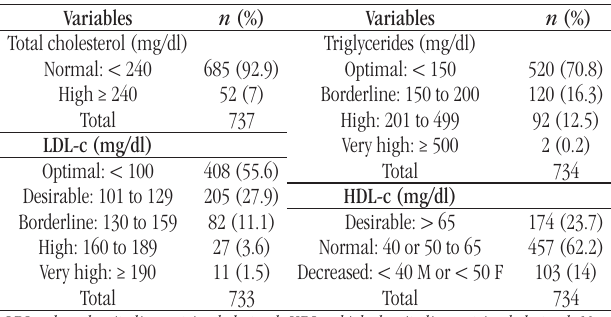
table 2 − Prevalence of results according to lipid